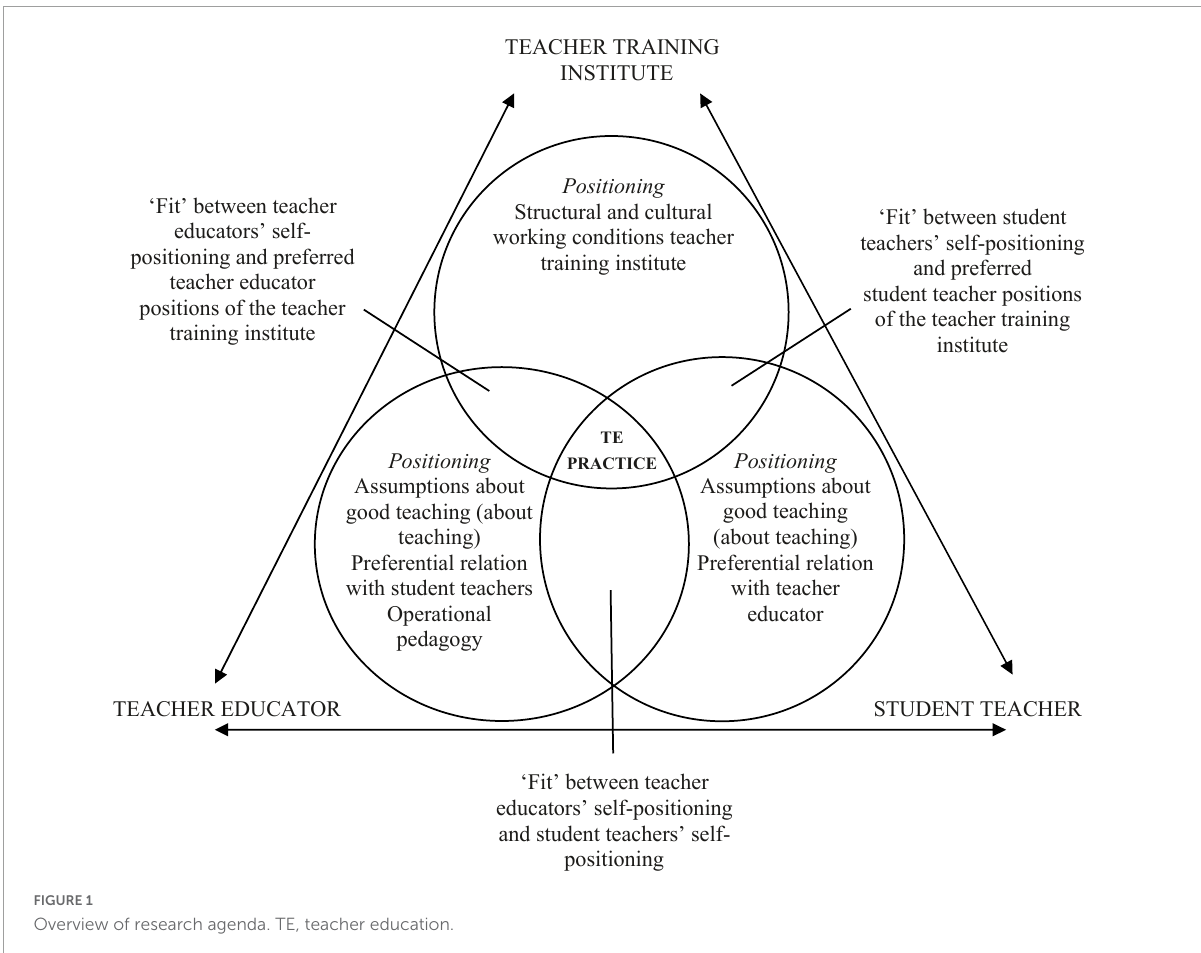
FIGURE1 Overview of research agenda. TE, teacher